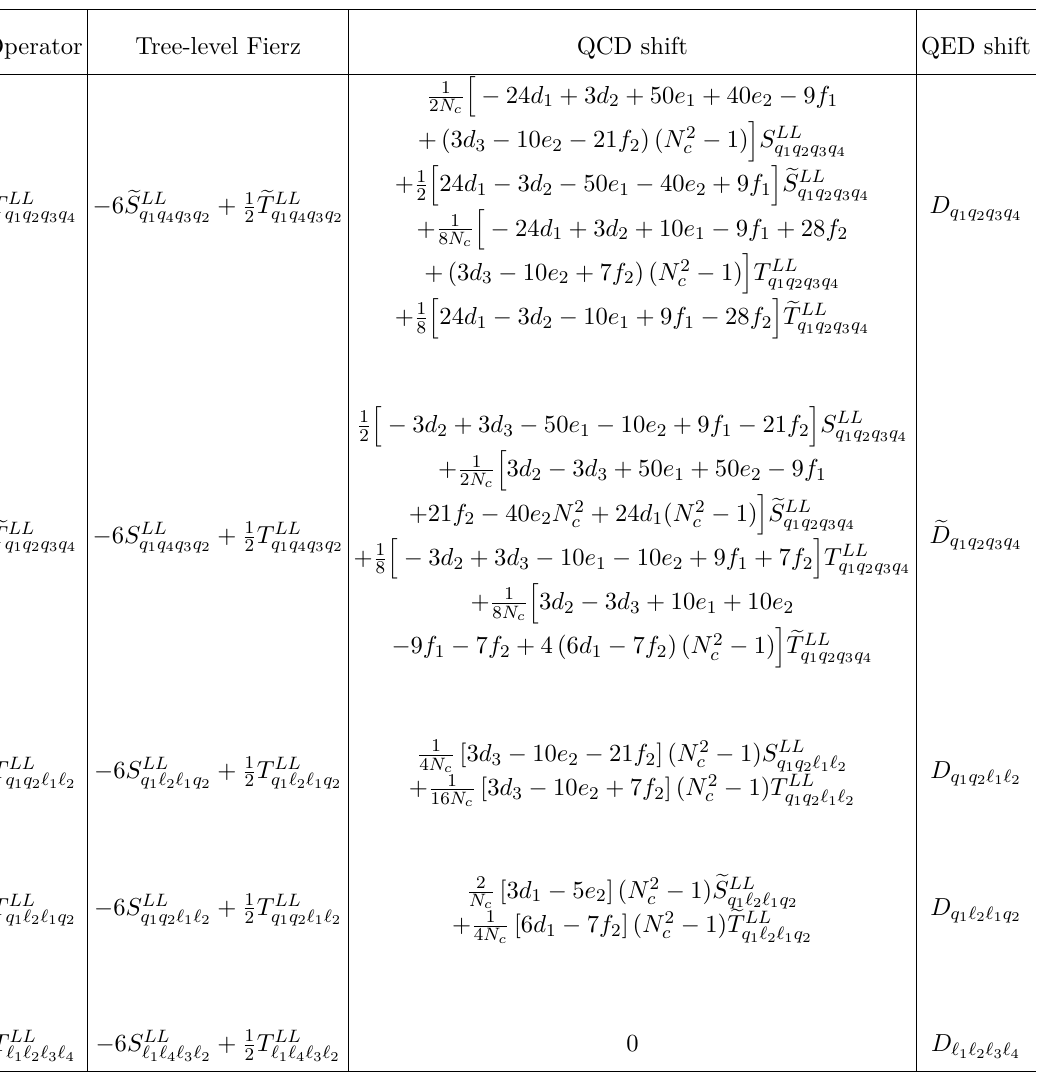
Table 10. Fierz transformations for tensor σ µν P L ⊗ σ µν P L operators together with their one-loop QCD and QED shifts in the generalised BMU